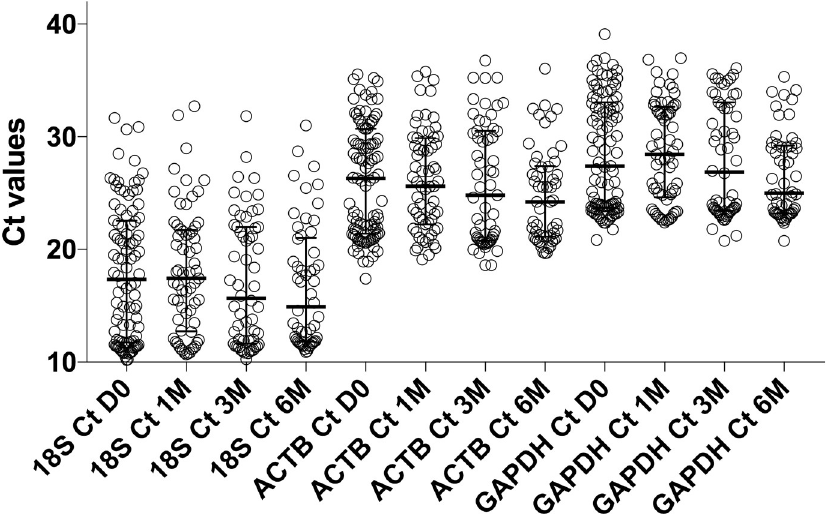
Fig 1. Ct values of the reference genes 18S , ACTB and GAPDH indicated no significant change in the median and IQR at all timepoints. https://doi.org/10.1371/journal.pone.0209516.g001 IQR at all timepoints (Fig 1). Based on this, we normalised our gene of interest Ct values to the average expression of the three reference genes at each timepoint. Thus, Delta Ct was calcu- lated using the formula: Delta Ct = Ct (gene of interest) at timepoint—Ct (average of reference genes) at timepoint, timepoint meaning day 0, 1M, 3M, 6M respectively. Transcripts that failed to amplify during the 40 cycles from all samples, were excluded from analysis. Next, we calcu- lated the fold change in the expression of each gene relative to day 0 of ART, using the formula: Fold Change = 2^ [(Delta Ct at timepoint)—(Delta Ct at D0)]. In order to account for the fact that we used bulk RNA extracted from whole blood to evaluate T cell specific genes, and that the CD4 T cell counts increased over time due to ART (Table 1), we further calculated the CD4 count corrected fold change using the formula: Corrected Fold change (at timepoint) = Fold Change / [(CD4 at timepoint / CD4 at D0)]. Increased gene expression is indicated by fold change values of > 1.